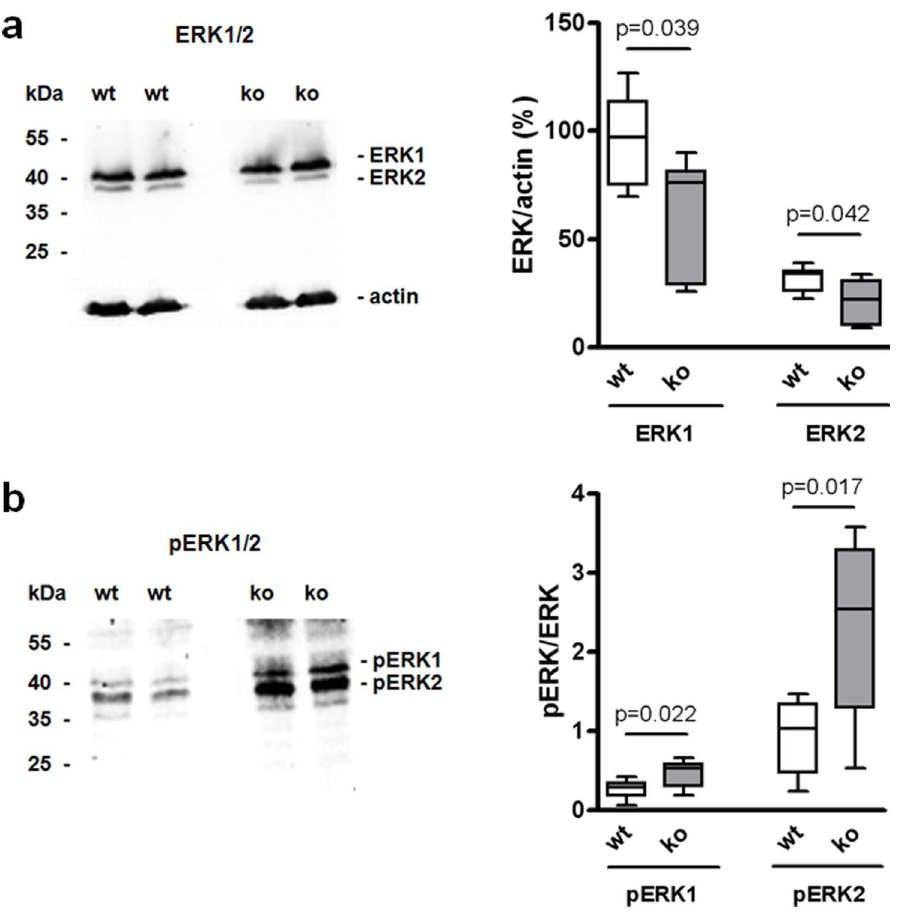
Figure 3. Striatal ERK1 and ERK2 expression are decreased in RGS9-deficient mice but phosphorylation is increased. ( a ) Total ERK1 and ERK2 from striatal homogenates of 3-month-old wt and RGS9-deficient mice was measured by Western blot quantification and normalized to actin. ( b ) Striatal phospho-ERK1/2 relative to total ERK1/2. Representative Western blots are shown, quantification was performed with n=7 per